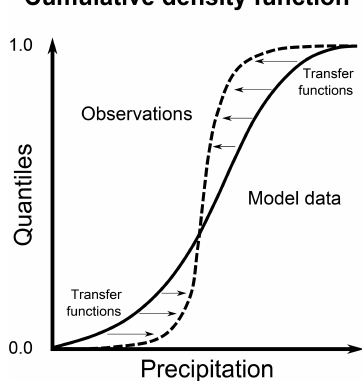
Figure 4. Diagram of the EQM technique. The solid (dashed) line shows a schematic simulated (observed) cumulative